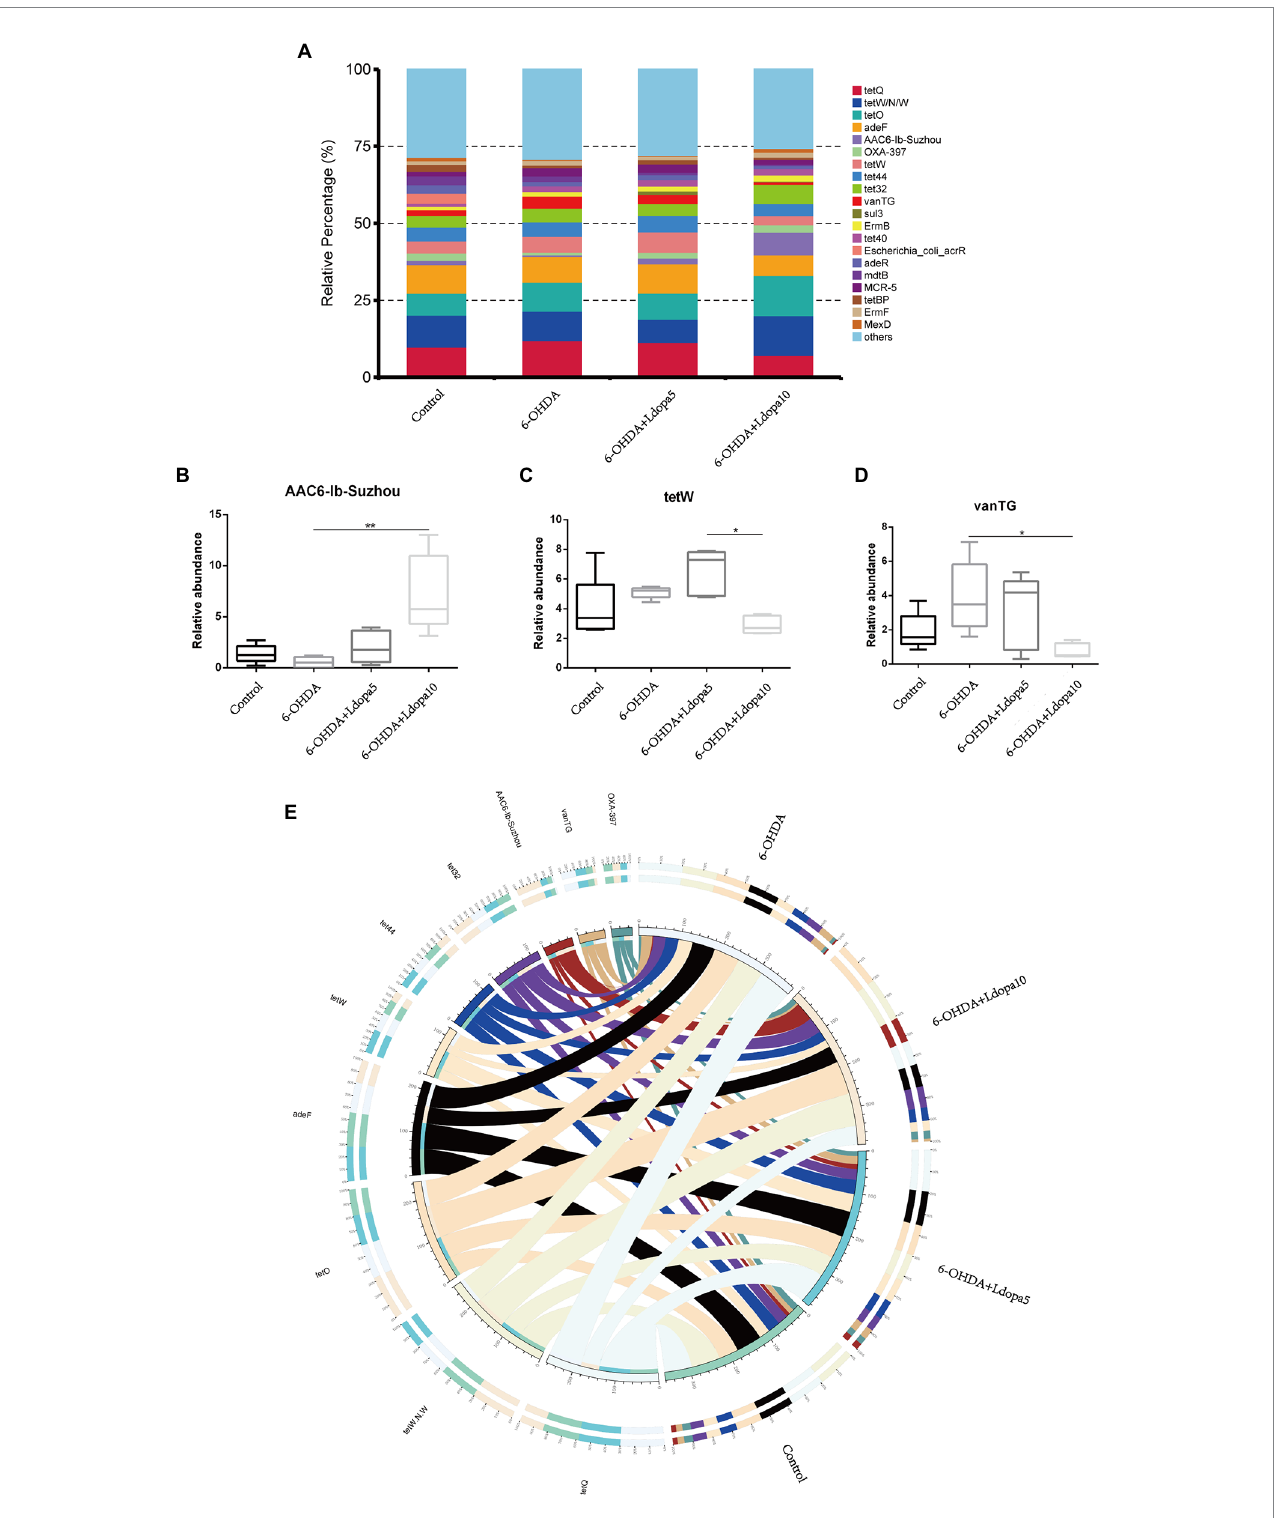
FIGURE 4 Relative abundances of the top 20 ARO were analyzed. (A) The relative abundance of top 20 ARO in control, 6-OHDA, 6-OHDA+Ldopa5 and 6-OHDA+Ldopa10 groups, the relative abundance of others is the sum of the relative abundance of non-top 20 ARO. (B–D) The relative abundance of differentially ARO in gut microbiota between 6-OHDA group and levodopa-treated 6-OHDA groups was discerned. The asterisks indicated statistical significance tested using one-way ANOVA followed by Dunnett’s test (* p < 0.05, ** p < 0.01). (E) The circle diagram was divided into two parts, the right is the group information and the left is the ARO information. Different colors of inner circle represent different groups and ARO, scale is the relative abundance, the left side of the inner circle is the sum of the relative abundance of each group of an ARO, and the right is the sum of the relative abundance of each ARO in a group. The left side of the outer circle is the relative percentage content of each group in an ARO, and the right side of the outer circle was the relative percentage content of each ARO in a